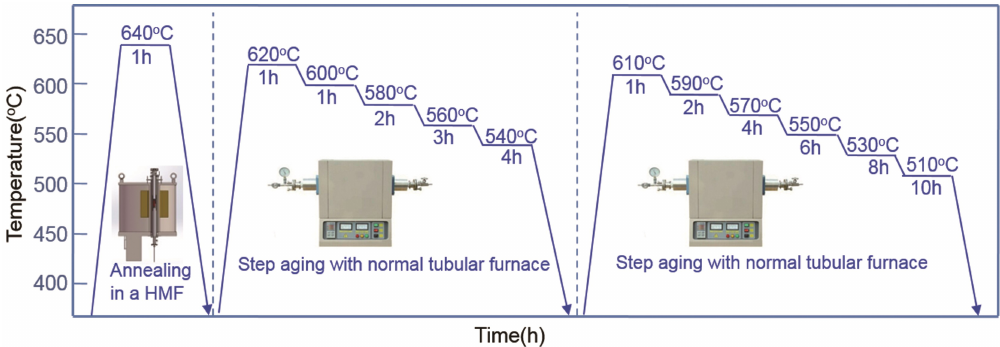
Figure 2. Schematic illustration of heat treatment used for the experiment.